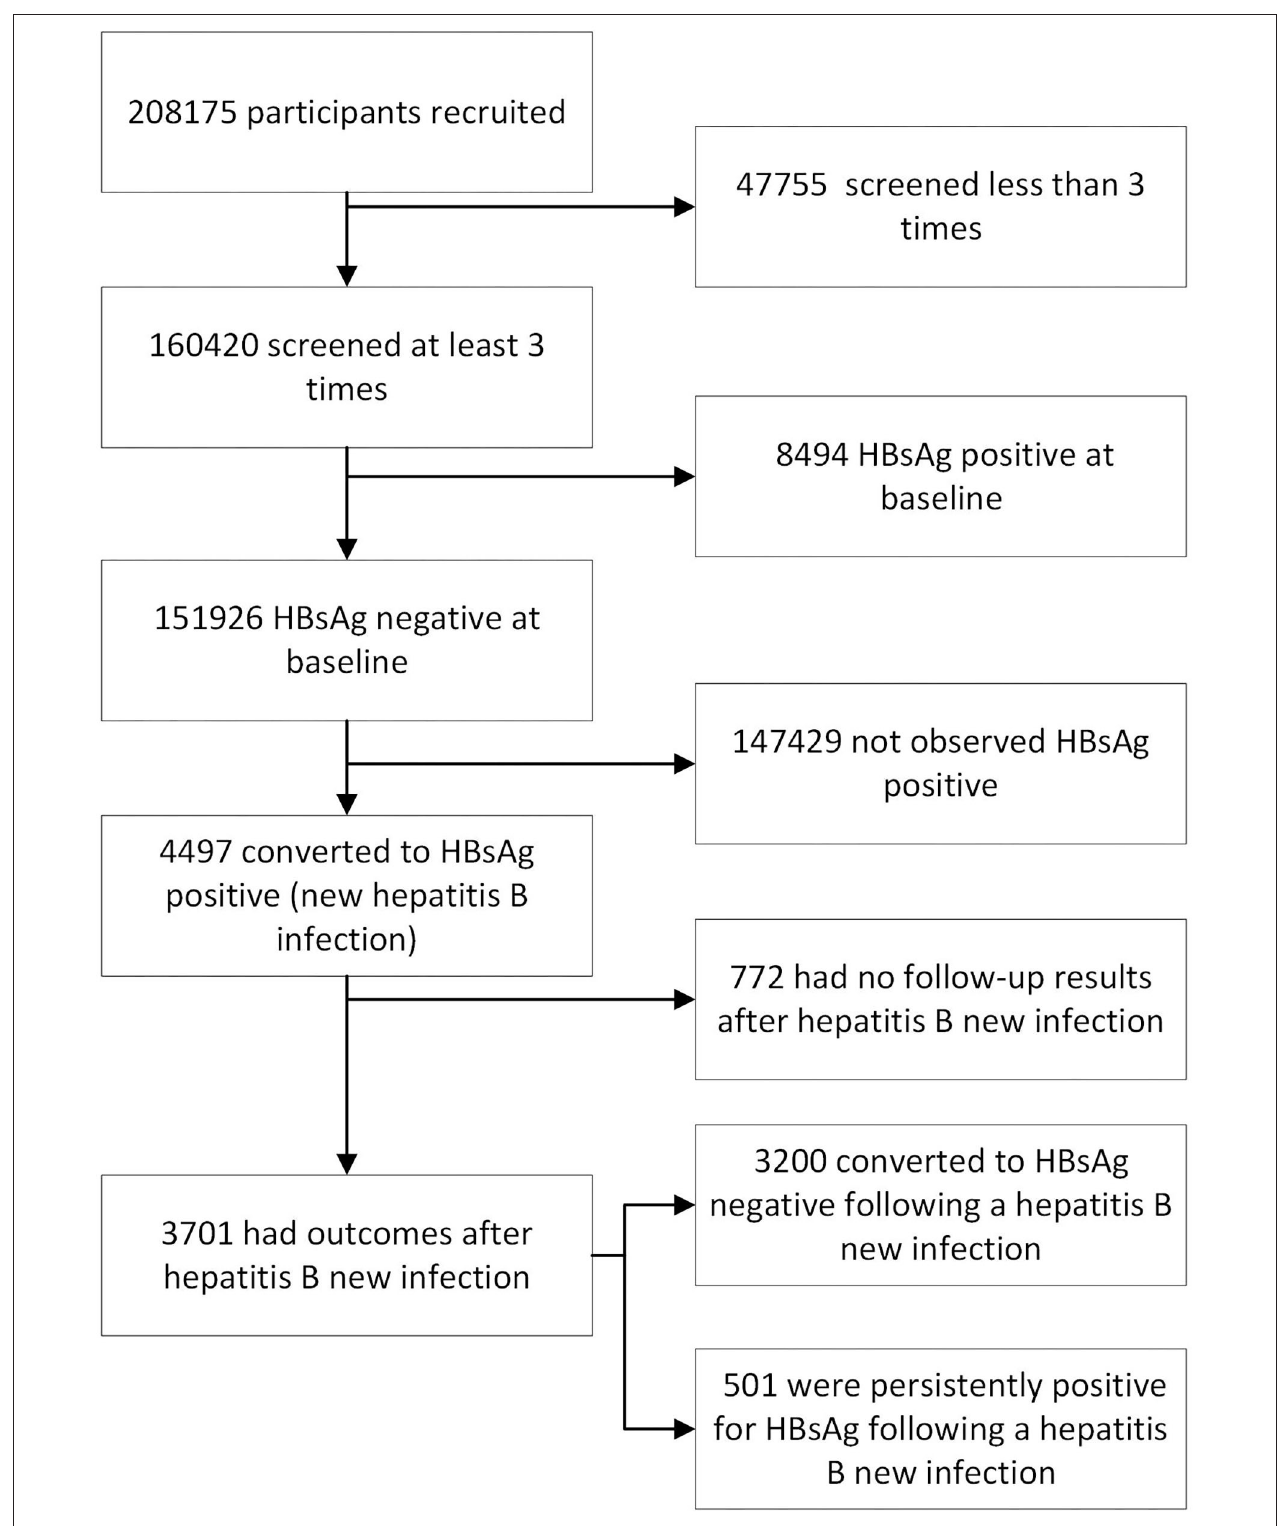
FIGURE 1 | The flowchart for this cohort study ( n = 208,175) of HBsAg status from 2010 to 2016 in Zhejiang Province, China.